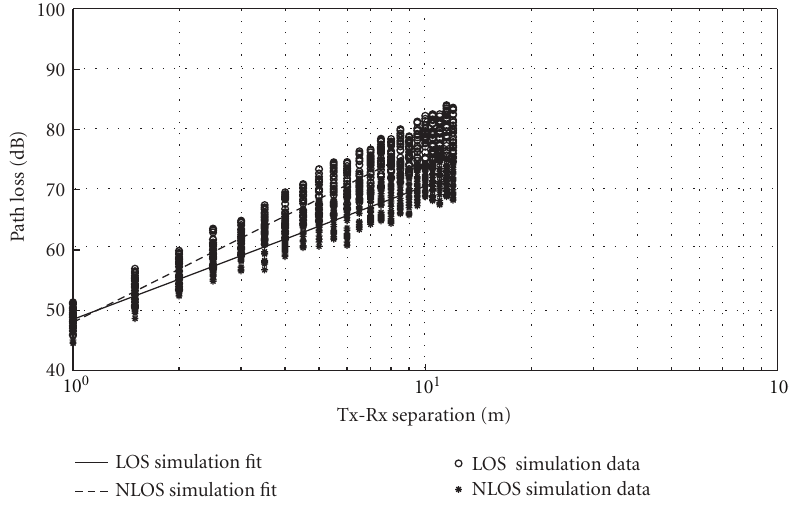
Figure 9: Scatter plots of simulation results at